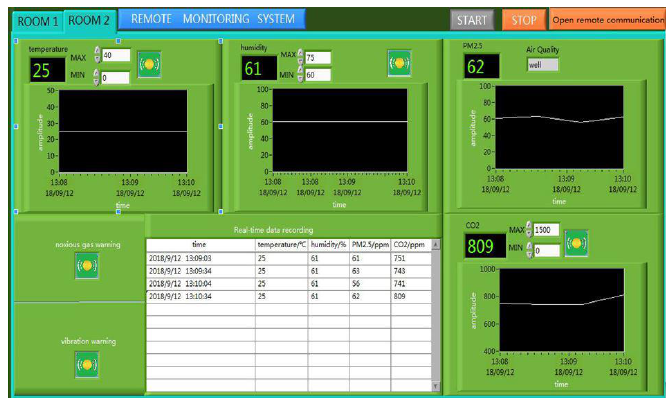
Figure 15. The server system.